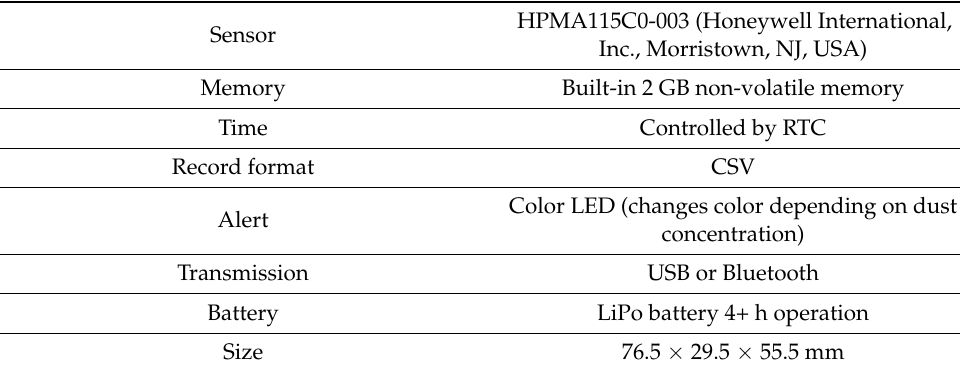
Table 1. Specifications of wearable particle monitor.